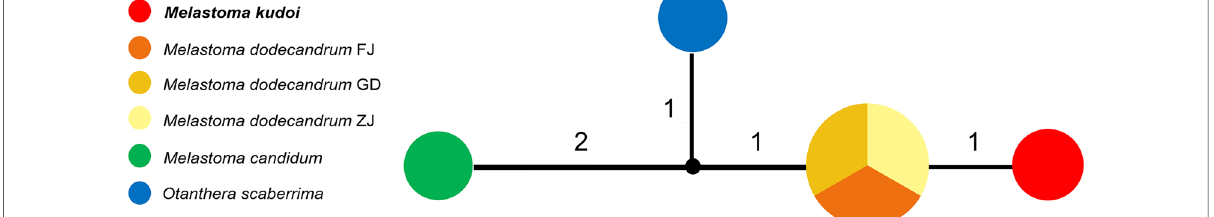
Fig. 5 Haplotype network of the combined chloroplast regions for the 6 populations. Haplotypes of each population are indicated by different colors. The numbers on the connecting lines denote the mutational steps. The black dot represents hypothesized haplotype. FJ, GD and ZJ denote the three sampling localities of M. dodecandrum